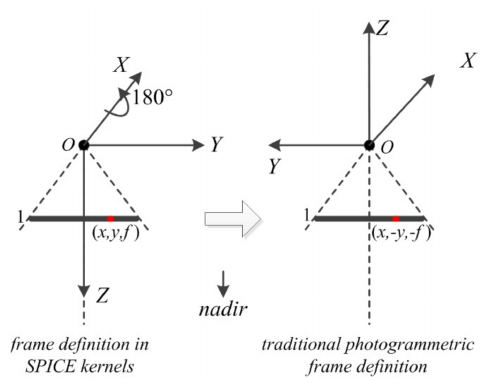
Figure 3. Converting the default frame definition acquired from Spacecraft, Planet, Instrument, C-Matrix, Events (SPICE) kernels to the traditional photogrammetric frame